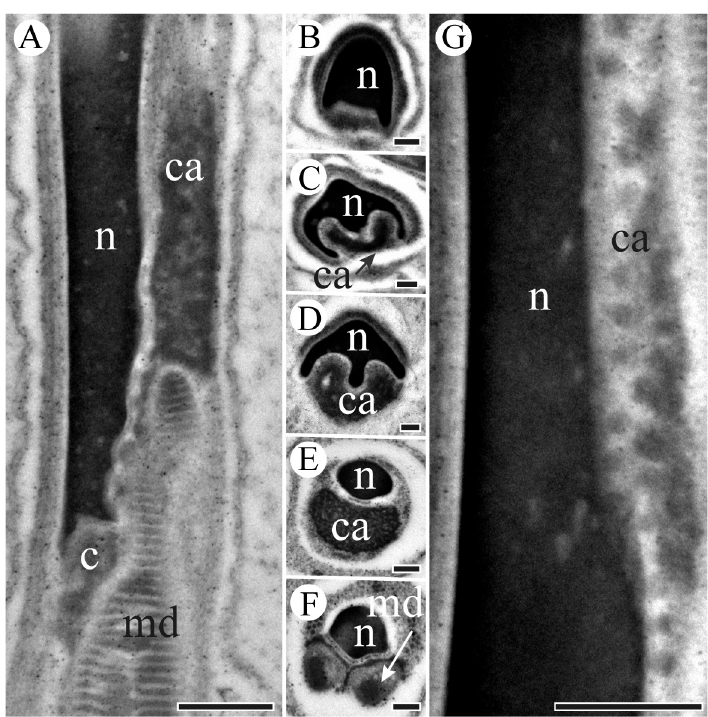
Figure 3. TEM micrographs of S. yangi sperm neck region. A Longitudinal section of the neck region, showing nucleus (n), centriole (c), granular centriolar adjunct (ca) and mitochondrial derivatives (md) B Cross-section anterior of the neck region, showing nucleus (n) C and D Cross-sections of the mid-neck region, showing nucleus (n) and centriolar adjunct (ca) E Cross-section through the terminal end of neck region, showing an eliptical nucleus (n) and a granular centriolar adjunct (ca) F Cross-section through the terminal end of neck region, showing a nucleus (n) and two mitochondrial derivatives (md) G Magnified longitudinal section of neck region, showing granular centriolar adjunct (ca) next to nucleus (n). Scale bars: 500 nm ( A, F, G ), 200 nm ( B–E